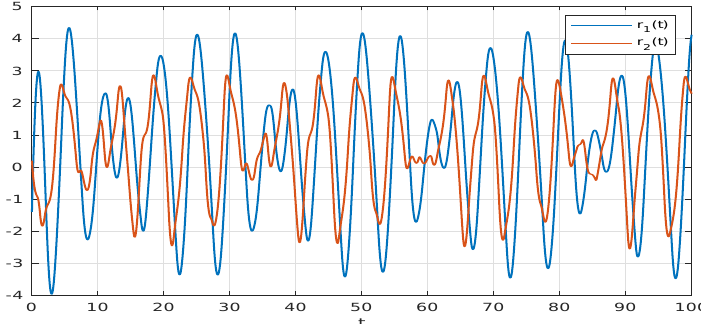
Figure 6. The synchronization error system without the controller.